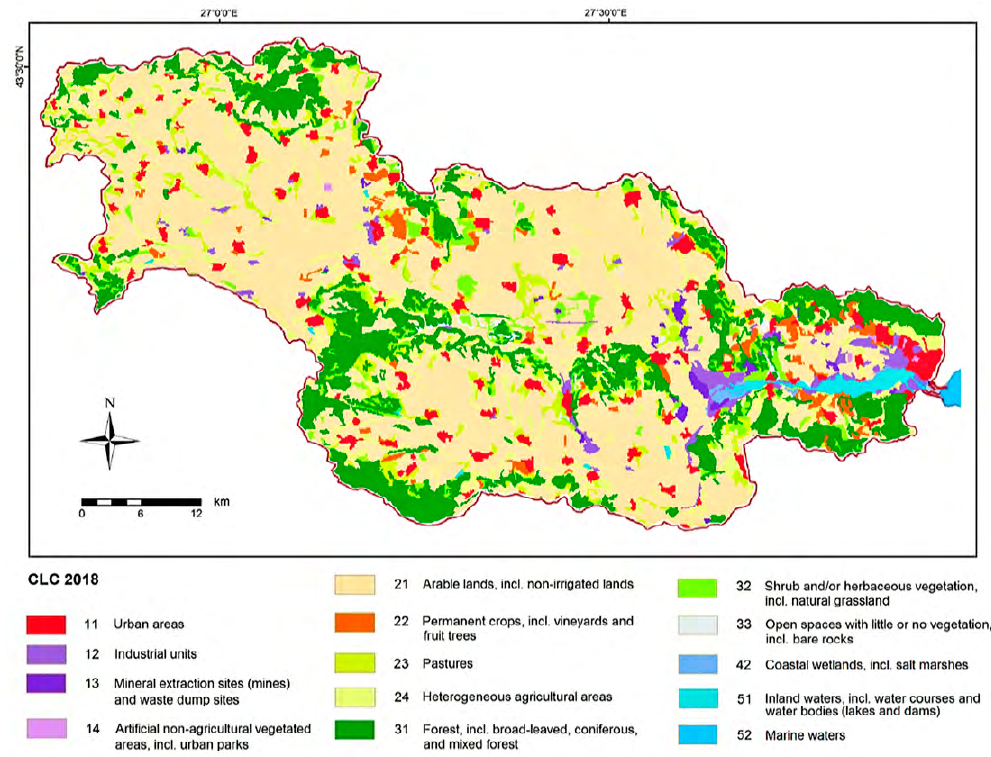
Figure 3. CORINE Land Cover (2018) of the Provadiyska River